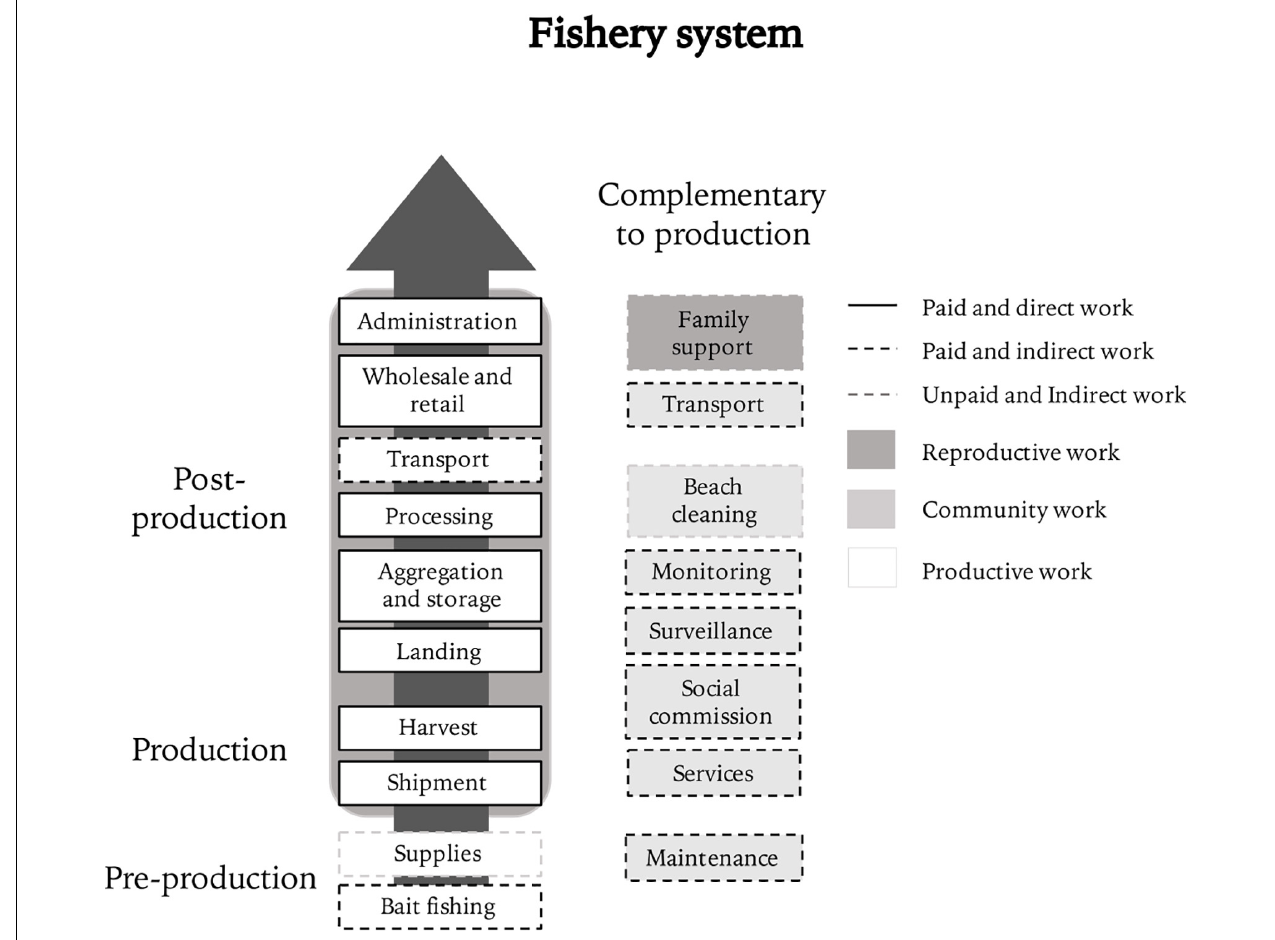
FIGURE 2 | Adapted value chain for the fishery system based on the FAO (2014) model.